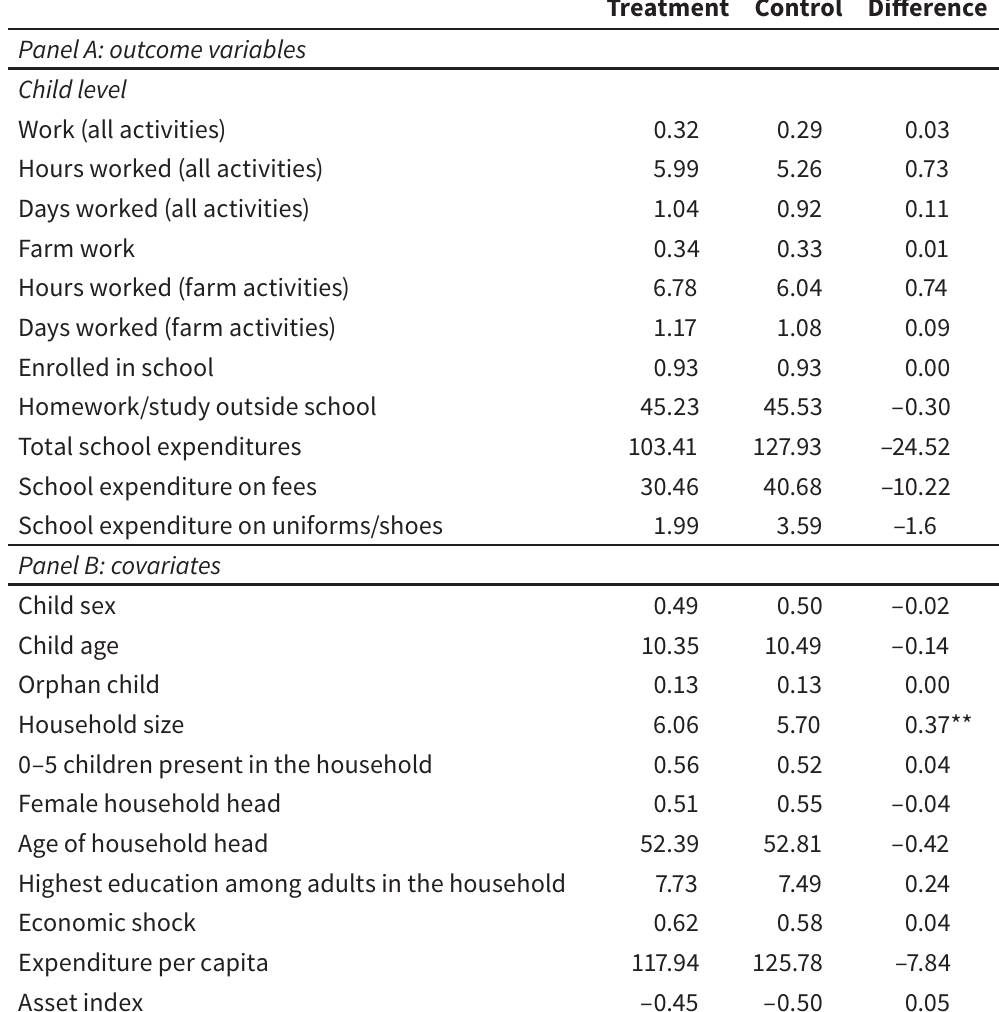
Balance analysis on eligible children at baseline